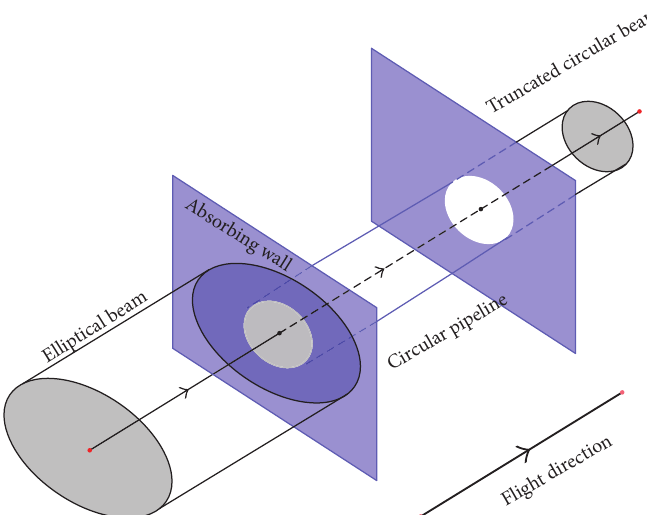
Figure 1: A classical particle beam with elliptical transversal profile is cut off upon entering a circular coaxial pipeline.